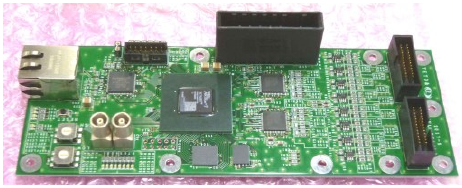
Fig. 3. NEUNET board.